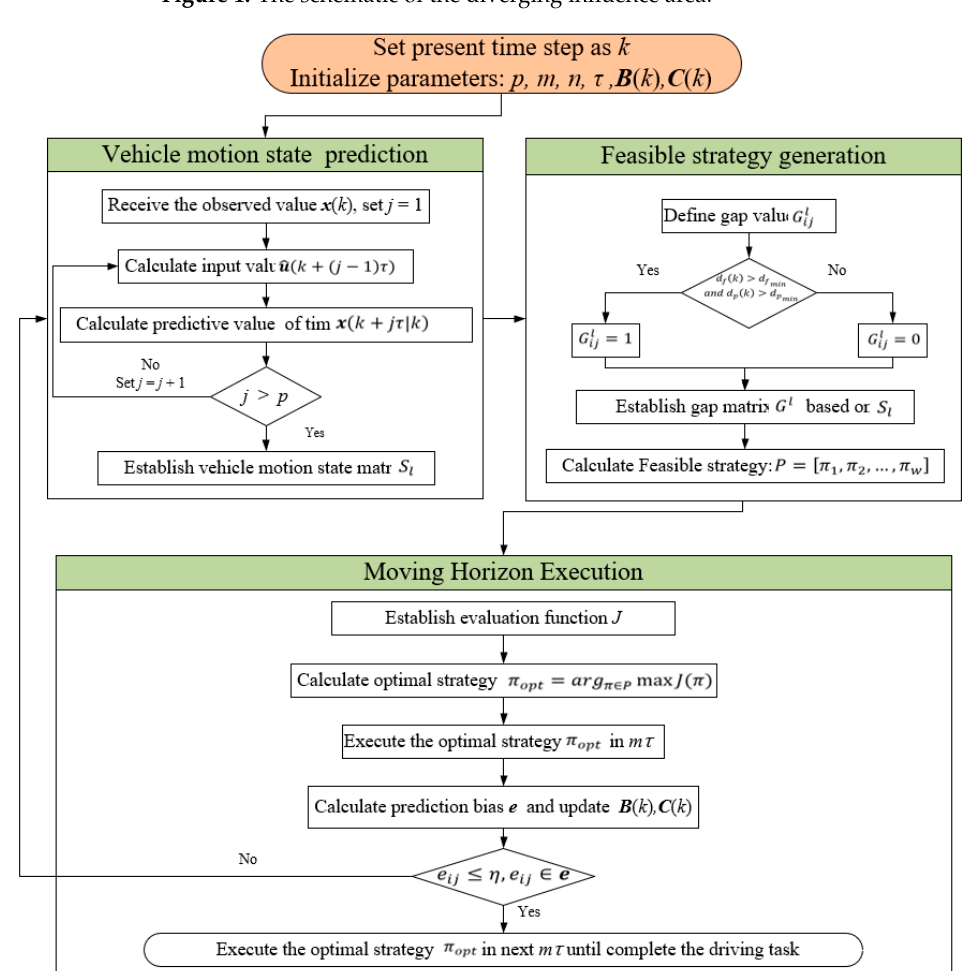
Figure 2. Methodology framework.